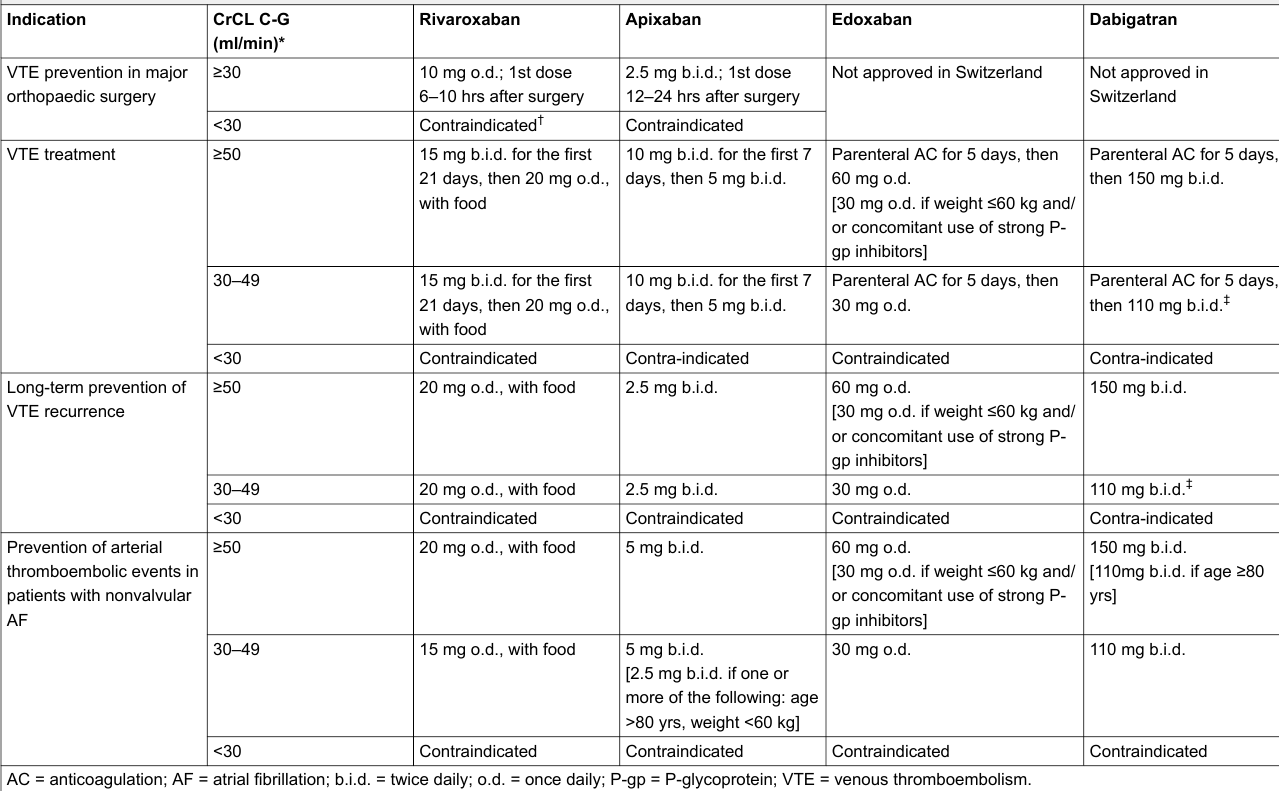
Table 2: Dosing of direct oral anticoagulants in clinical practice.